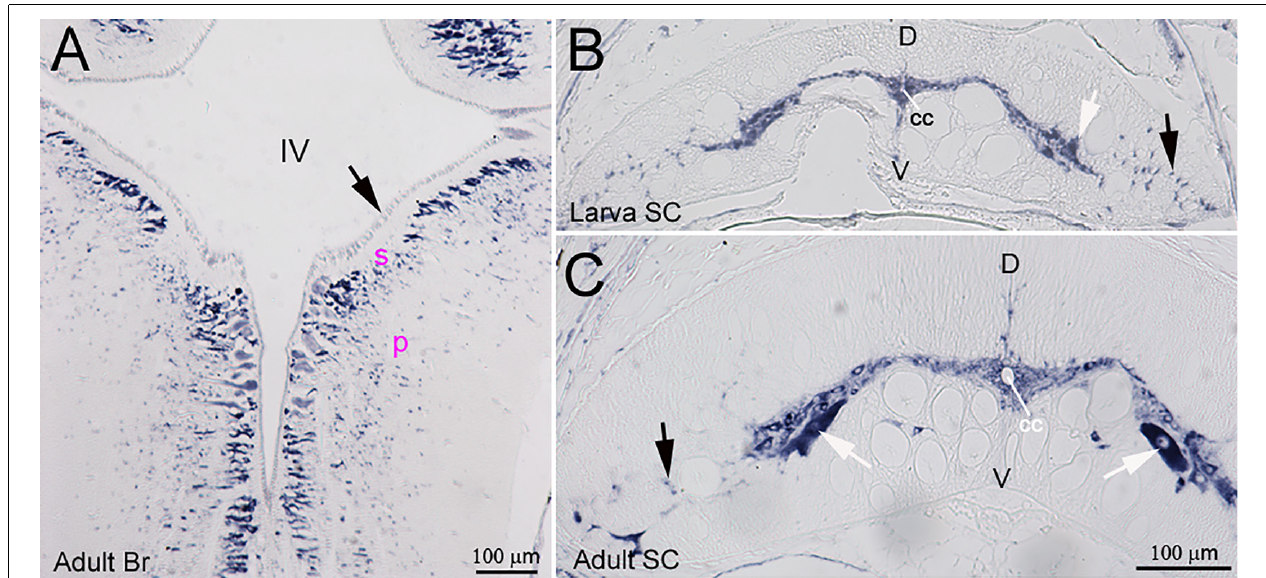
FIGURE 2 | Distribution of lectican mRNAs in lamprey CNS. ISH using probe 1 shows broad expression of lectican mRNAs in lamprey brain and spinal cord. (A) A horizontal section of an adult brain (Br) shows that lectican mRNAs are expressed in neurons and glia but only weakly in the ependyma (arrow), IV = 4th ventricle; s = subventricular zone; p = peripheral zone. Transverse sections of spinal cord (SC) from a larva (B) and an adult (C) show that lectican mRNAs are expressed in SC neurons (white arrows) and glia (black arrows) and that the level of lectican mRNAs is higher in adult SC than in larval SC. D = dorsal; V = ventral; cc = central